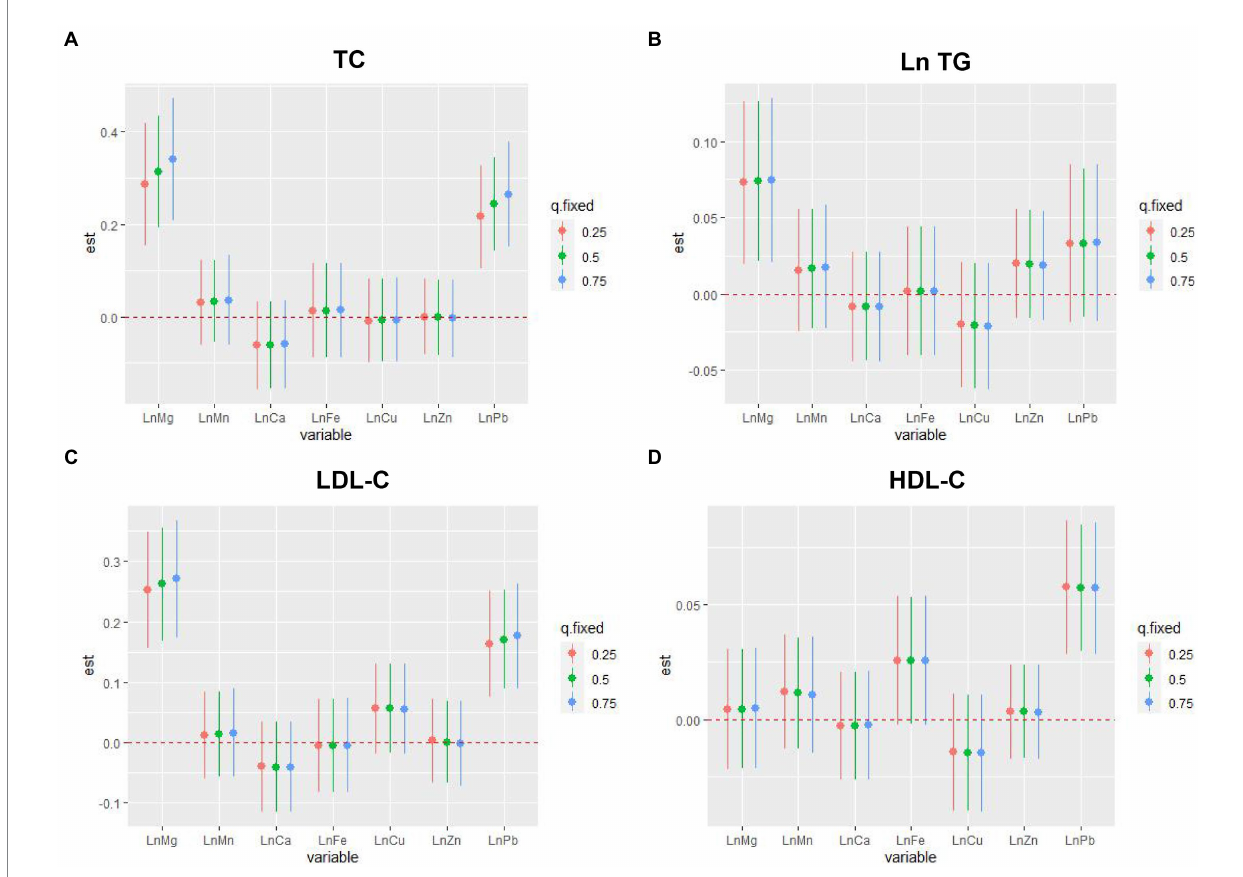
FIGURE 4 The single-exposure associations of individual metal with serum lipid profiles by the BKMR model. (A) Metal mixture and TC, (B) metal mixture and Ln TG, (C) metal mixture and LDL-C, and (D) metal mixture and HDL-C. TG, blood Pb and essential metal concentrations were transformed to natural logarithm for further analysis. The model was adjusted for age, sex, educational, smoking status, abuse drinking, BMI categories, diabetes, and hypertension. The associations were analyzed when all the other exposures were fixed to 25th, 50th, and 75th percentile. The 95% confidence interval of the estimate does not include 0 is considered statistically significant. TC, total cholesterol; TG, triglyceride; LDL-C, low-density lipoproteins cholesterol; HDL-C, high-density lipoproteins cholesterol; BMI, body mass index; Mg, magnesium; Mn, manganese; Ca, calcium; Fe, iron; Cu, copper; Zn, zinc; Pb,